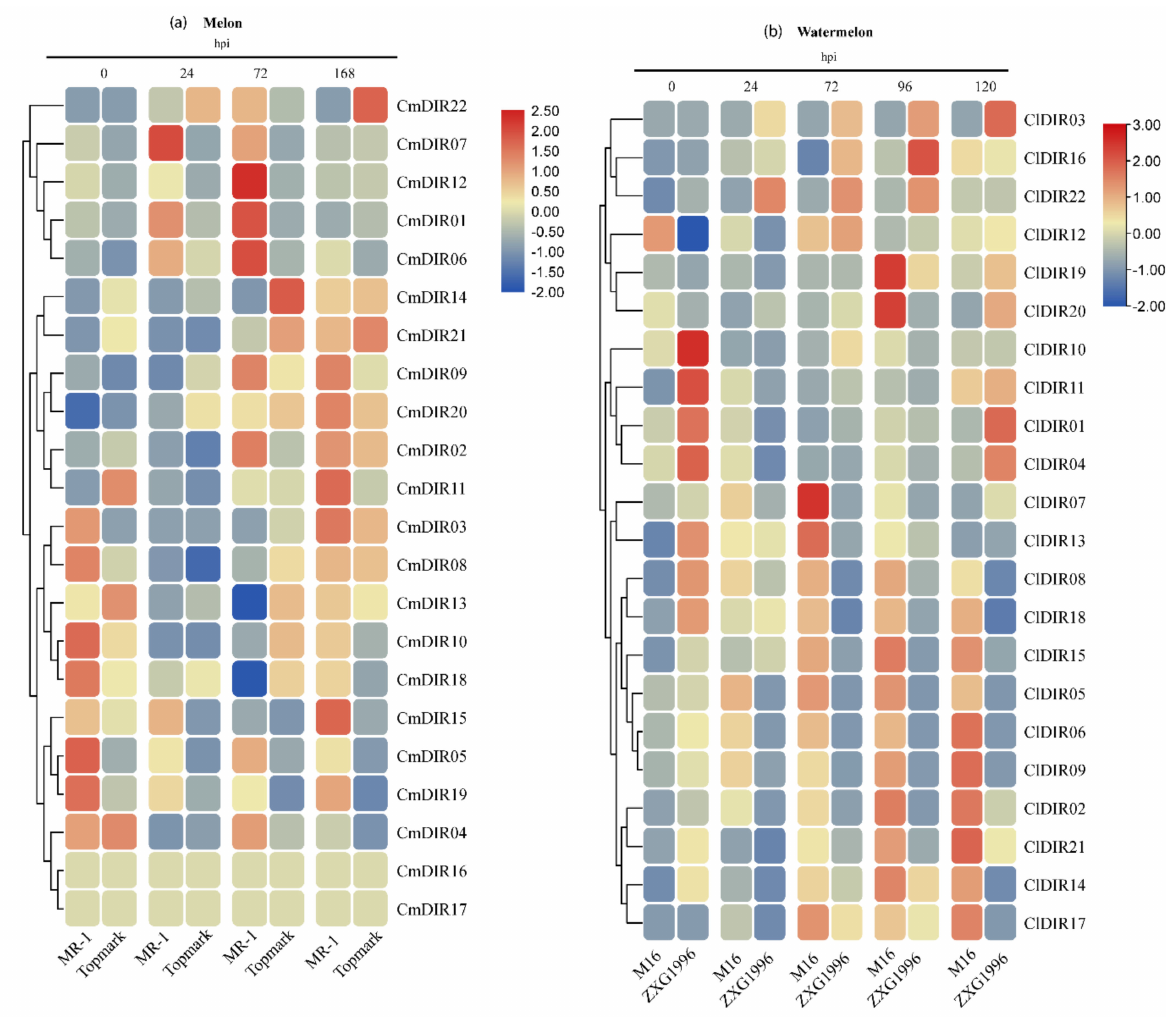
Figure 8. Heatmap of transcription profiling (Log2-based RPKM values (melon) and qRT-PCR (watermelon)) of CmDIR and ClDIR genes in resistant and sensitive cultivars of C. melo and C. lanatus . ( a ) The heat map representing response of MR-1 (resistant) and Topmark (susceptible) cultivars after different times (hours) post inoculation. ( b ) Heatmap generated from the qRT-PCR data (log2 transformed) obtained from M16 (resistant) and ZXG1996 (susceptible) cultivars of watermelon after PM